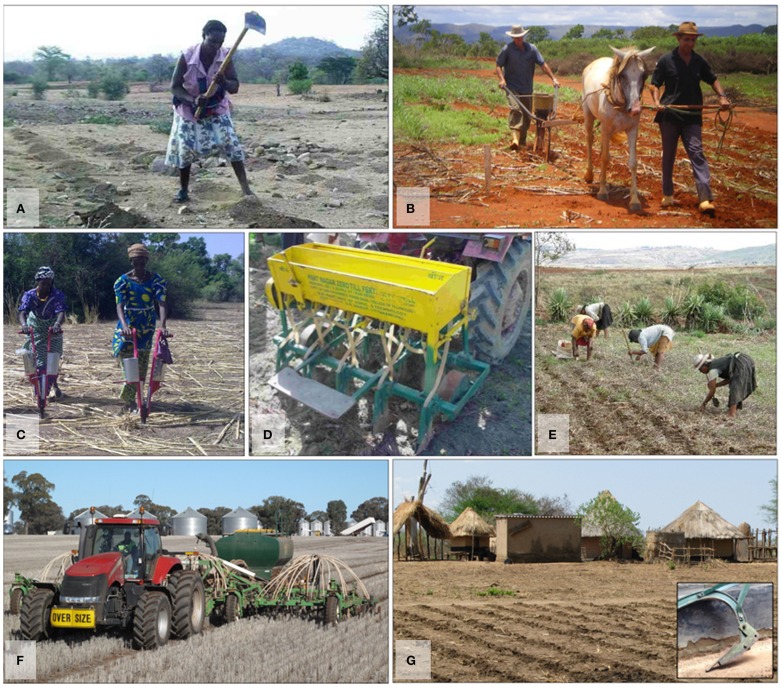
The many forms of Conservation Agriculture across the globe. (A) Digging planting basins using a hoe in Zimbabwe. Note the absence of crop residues. (source: Jens A. Andersson); (B) Seeding on no-tilled soil with a direct seeder and fertilizer distributor in Parana, southern Brazil. (source: CIRAD, France); (C) Direct seeding on no-tilled soil using a jab planter in Burkina Faso (source: Patrice Djamen, ACT, Kenya); (D) Tractor drawn zero-till seed-cum-fertilizer drill in the Indo-Gangetic Plains, India (source: Olaf Erenstein, CIMMYT, Mexico); (E) Direct seeding using a pointed stick in Madagascar (source: Eric Penot, CIRAD, France); (F) No-till, controlled traffic crop sowing in Australia using a disc-seeder with satellite guidance with 2 cm accuracy to sow between the rows of previous crop stubble. (source: CSIRO and Grass Roots Agronomy, Australia); (G) Field of smallholder farmer in Zimbabwe that has been minimally tilled using a Magoye ripper (see inset photo). (source: Jens A. Andersson).